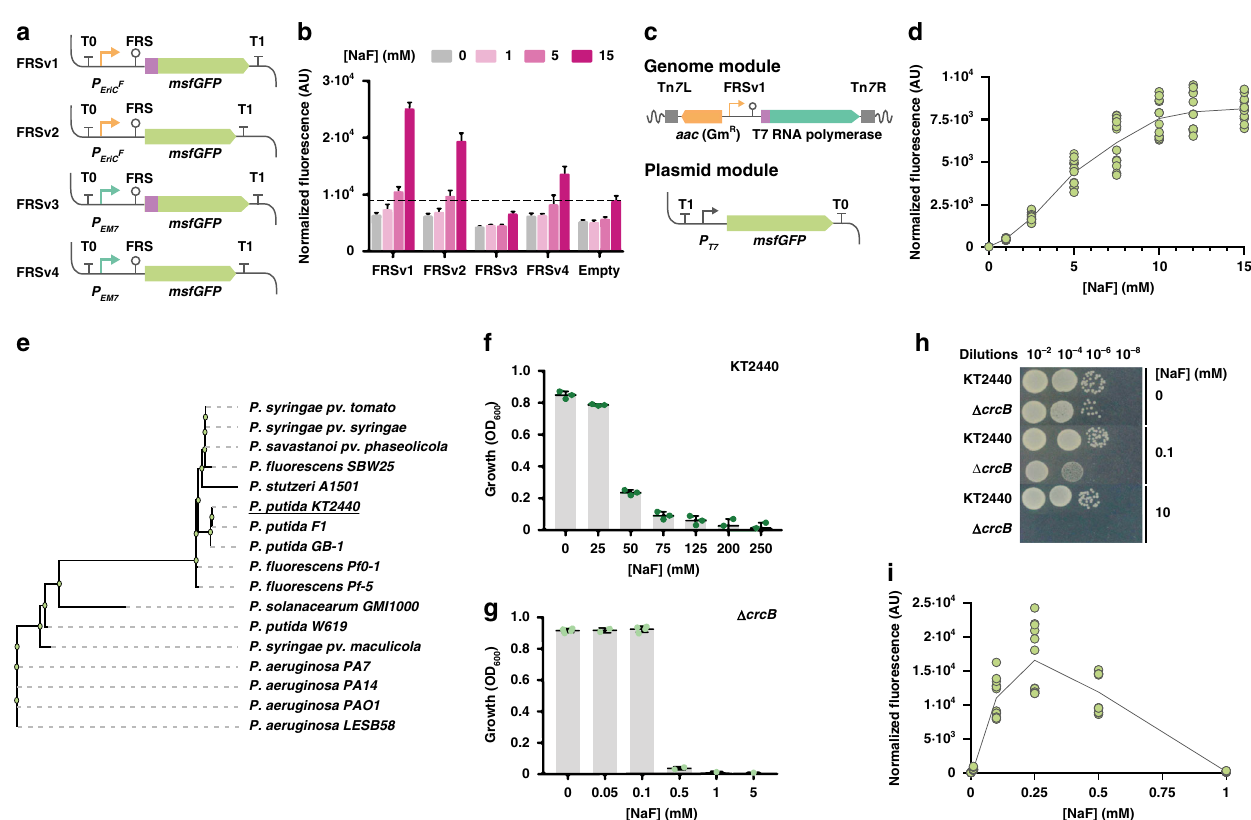
Fig. 1 Construction and characterization of a fl uoride-responsive gene circuit. a Constructs bearing the F − responsive riboswitch (FRS) with different combinations of the native eriC F promoter ( P eriC F , orange arrows) or a constitutive, synthetic promoter ( P EM7 , dark green arrows) and the sequence encoding the fi rst eight amino acids of EriC F (purple box) were tested. The msfGFP sequence and transcriptional terminators are indicated in light green and T symbols, respectively. b Normalized fl uorescence of P. putida KT2440 transformed with the FRS constructs shown in ( a ) in response to different NaF concentrations. The fl uorescence baseline (empty vector) is marked with a dashed line; data are presented as mean values and error bars represent standard deviations of three different biological replicates. ( c ) Synthetic circuit based on the FRS and the T7 RNA polymerase. FRSv1 regulates the expression of the T7 RNA polymerase gene (dark green), encoded in a mini-Tn 7 module (left and right sites of mini-Tn 7 depicted as dark gray boxes), along with a gentamycin resistance cassette (orange). This module is genome-integrated in P . putida ; a plasmid module containing P T7 → msfGFP (pS231T7::msfGFP) was transformed in the same strain. d Normalized fl uorescence of P. putida KT2440::FRS-T7RNAP/pS231T7::msfGFP exposed to increasing NaF concentrations. Data are presented as mean values and error bars correspond to standard deviations from three biological replicates. e Phylogenetic tree for CrcB proteins in Pseudomonas species. f Toxicity of F − in P. putida KT2440 grown in M9 minimal medium with different NaF concentrations. Bacterial growth (optical density at 600 nm, OD 600 ) is shown after 20 h of incubation. Error bars represent standard deviations of three biological replicates. g Same as in ( f ), but with P. putida KT2440 Δ crcB . Error bars represent standard deviations of at least n = 2 different biological replicates h Tolerance of P. putida KT2440 and P. putida KT2440 Δ crcB to NaF exposed by spotting culture dilutions onto LB medium plates containing 0, 0.1, and 10 mM NaF. i Same as in ( d ), but with P. putida KT2440 Δ crcB ::FRS-T7RNAP. Data are presented as mean values and error bars correspond